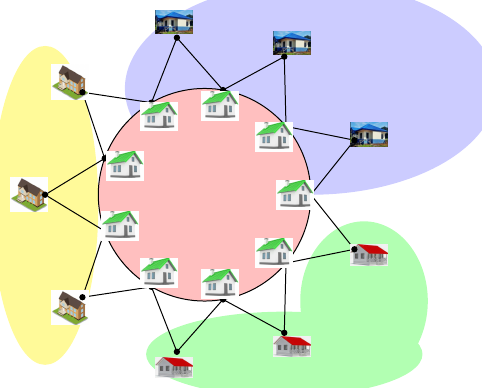
Figure 4. f 9 × 3 for fault-tolerant partition